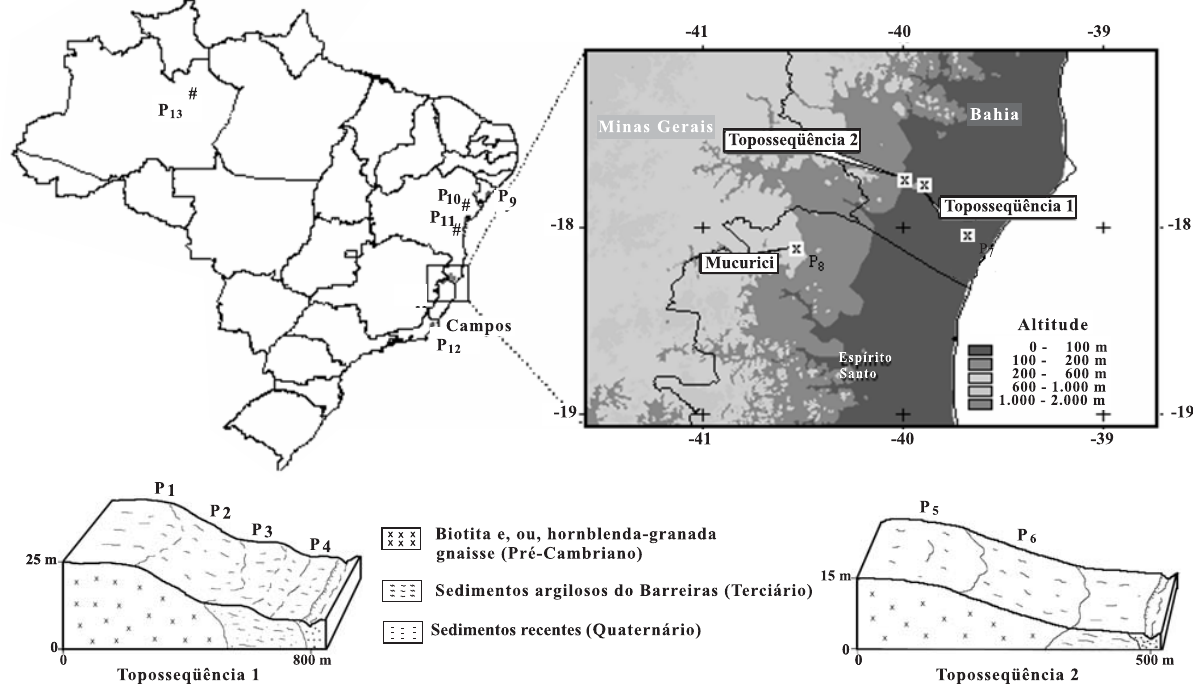
Figura 1. Localização dos perfis coletados e representação de suas